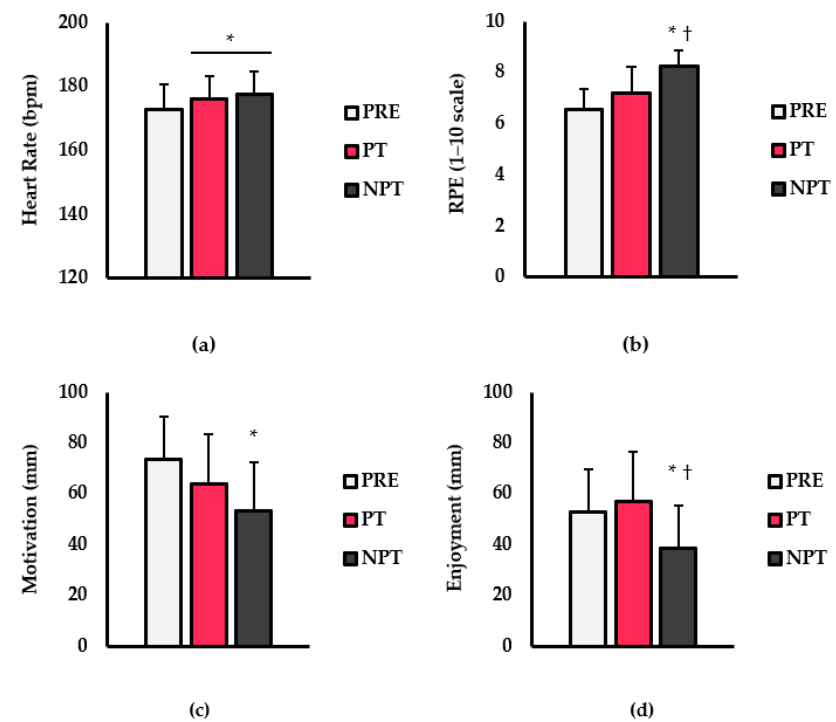
Figure 2. Differences in ( a ) Heart rate (HR; bpm), ( b ) Rate of perceived exertion (RPE; 1–10 scale), ( c ) Motivation (mm), and ( d ) Enjoyment (mm) between pre-taste (PRE; light grey bars), preferred taste (PT; pink), and non-preferred taste (NPT; dark grey) conditions. Data are presented as mean ± SD. † indicates significantly different from PT ( p < 0.05). * indicates a significantly different from PRE ( p < 0.05).